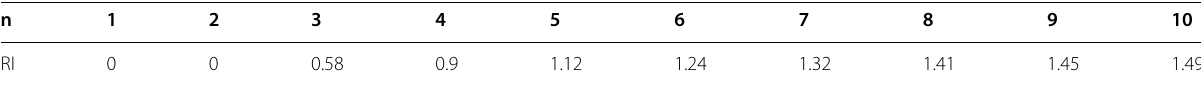
Table 4 Random inconsistency index